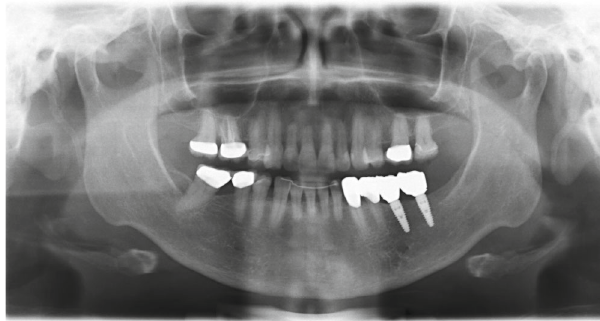
Figure 19: X-ray check 3 years after implant